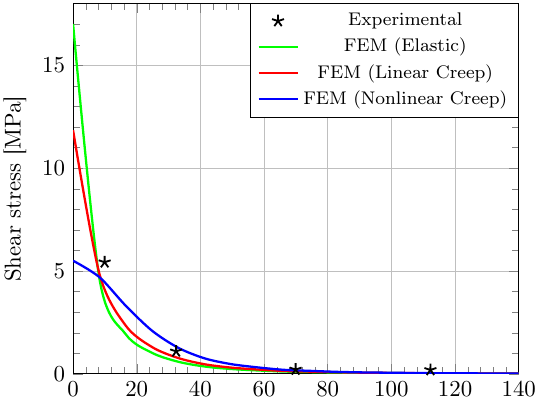
Figure 8. Shear stress profile along the bonded joint after a creep period of 30 days. Experimental data and simulations provided by the FE model considering different behaviors of the adhesive